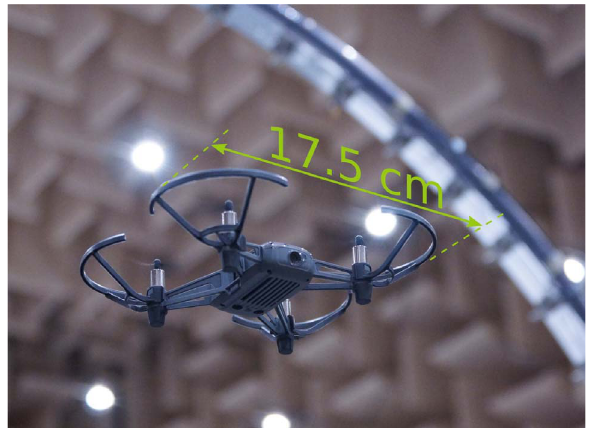
Figure 5. Drone used for the measurement. The rotor diameter is 7.7 cm.